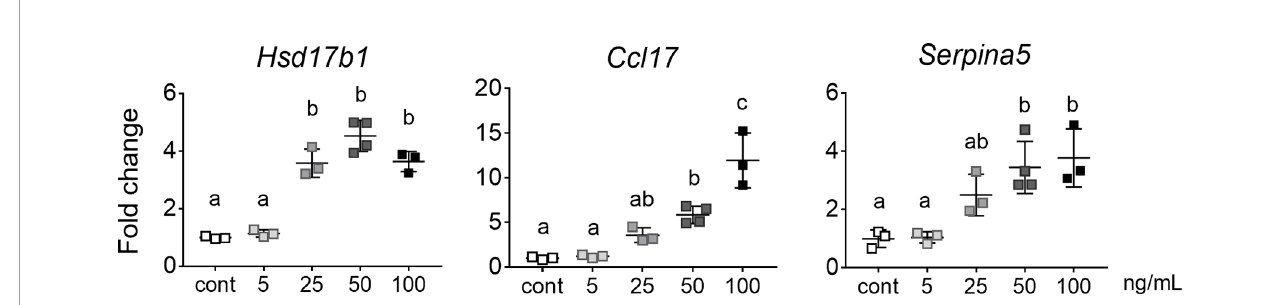
FIGURE 4 | Dose-dependent response of activin A target genes. qRT-PCR analysis of transcripts of E13.5 whole gonads exposed to 5 to 100 ng/mL activin A for 48 hours in culture and compared with control (n=3 or 4 per group). Data were normalised to the Canx housekeeper and expressed as fold change compared to control (no activin A). Data are presented as mean ± SD, and signi fi cance was determined by one-way ANOVA following the Shapiro-Wilk normality test. Signi fi cant differences are indicated by different